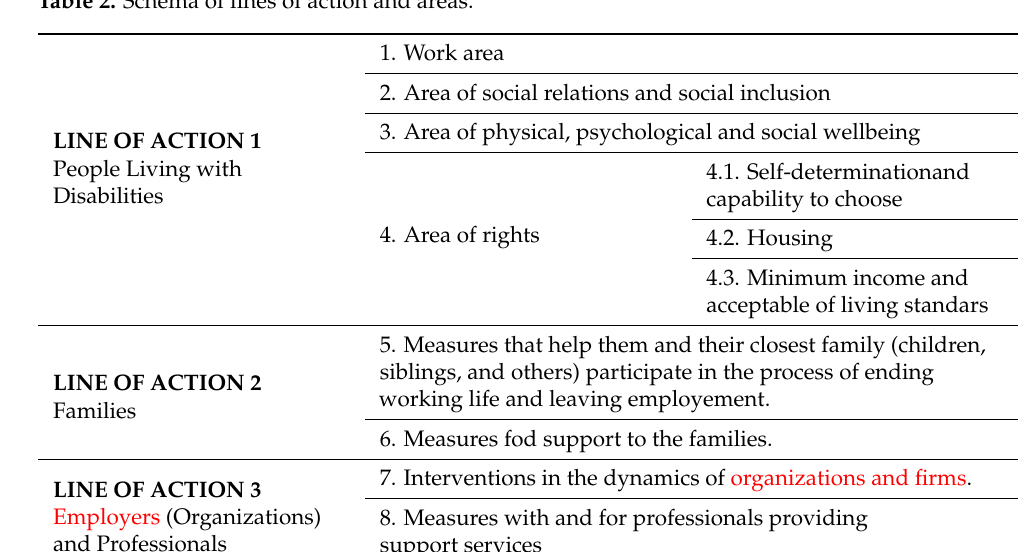
Table 2. Schema of lines of action and